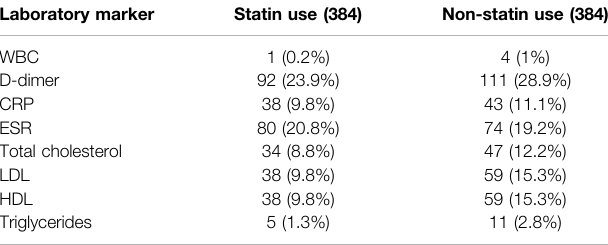
TABLE 1 | Missing laboratory markers in the propensity-matched